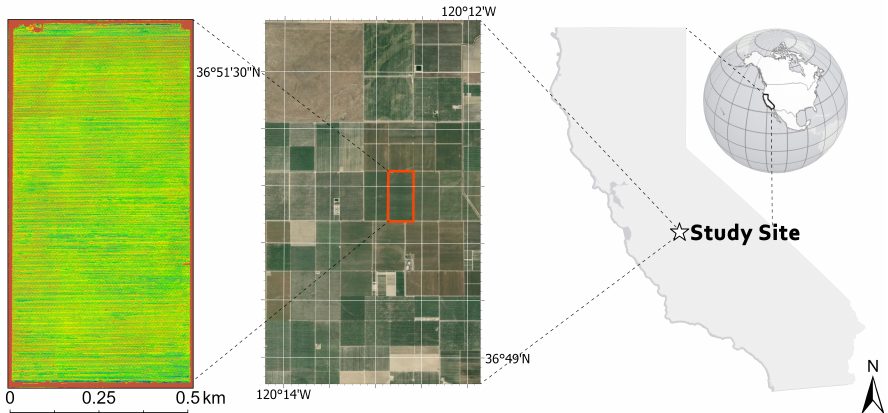
Figure 2. Site map of Ripperdan 760 Block in Madera County, California,